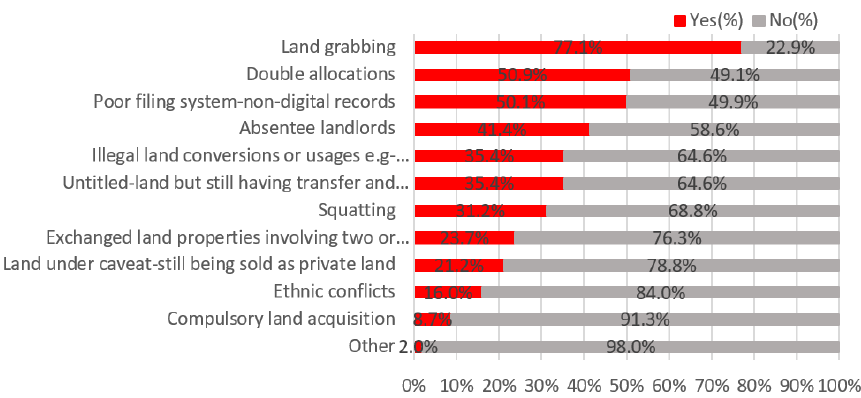
Figure 7. Emerging issues on land ownership.